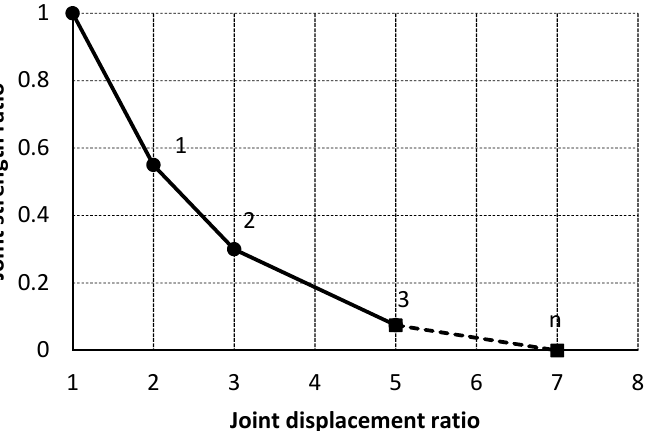
Figure 3. Non-dimensional post-peak weakening behavior defined by linear segments: joint strength ratio vs. joint displacement ratio.